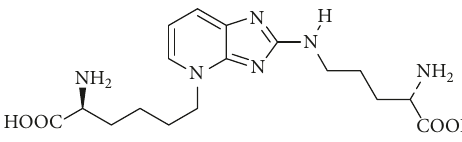
Figure 1: Chemical structure of